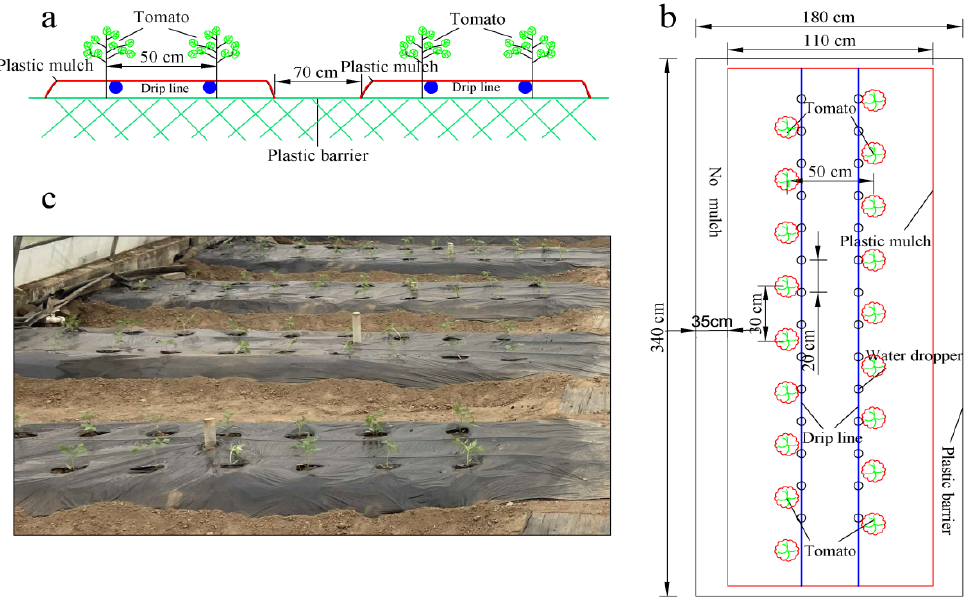
Figure 1. ( a ) Section map of tomato planting, drip-line arrangements, and planting plot; ( b ) the planform for tomato planting and drip-line arrangements in a planting plot; ( c ) field figure of tomato experiments in greenhouses.